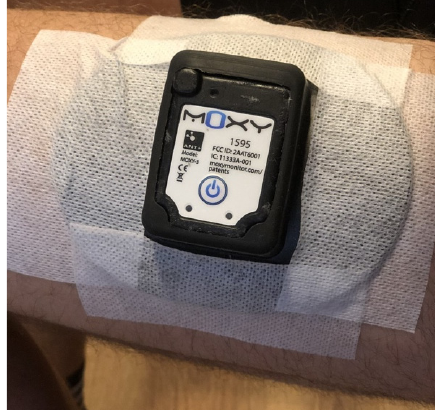
Figure 1. Moxy monitor placement . Three NIRS monitors were placed and affixed using double-sided adhesive tape over the left (dominant) VL, PM, and LD muscles: for the VL, on the distal part of the VL muscle belly (10 cm above the proximal border of the patella); for the PM, on the center of the muscle belly along in the principal direction of the muscle fibers of the sternocostal head, and for the LD, on the midpoint between the inferior border of the scapula and the poste- rior axillary fold. The skinfold thickness at each site was measured using a skinfold caliper (Harpenden, C-136) to ensure that the skinfold thickness was less than half the distance between the emitter and the detector (25 mm). The raw muscle O 2 saturation (SmO 2 ) and total hemoglobin concentration (tHb) signals were captured at 10 Hz, and the data were smoothed using a 10th order low pass-zero phase Butterworth filter (cut-off frequency 0.1 Hz) provided by the recording Artinis Software (Oxysof, Artinis Medical System, Elst, The Netherlands) [39]. Black elastic bandages were used to shield the probes from ambient light and minimize movement during exercise. The values of muscles oxygenation at the baseline (averaging 30 s before exercise), during exercise (sample size of each bout n = 180), and during exercise recovery periods (sample size of each bout n = 180) were rec- orded in the Moxy PC software (Fortiori Design LLC, Minneapolis, MN, USA), which al- lowed for the calculation of the average of the recorded values and the lowest point of the SmO 2 in each training. The variation between recovery and exercise in SmO 2 ( Δ SmO 2 ) was calculated by evaluating the difference between the minimum SmO 2 and baseline SmO 2 ,